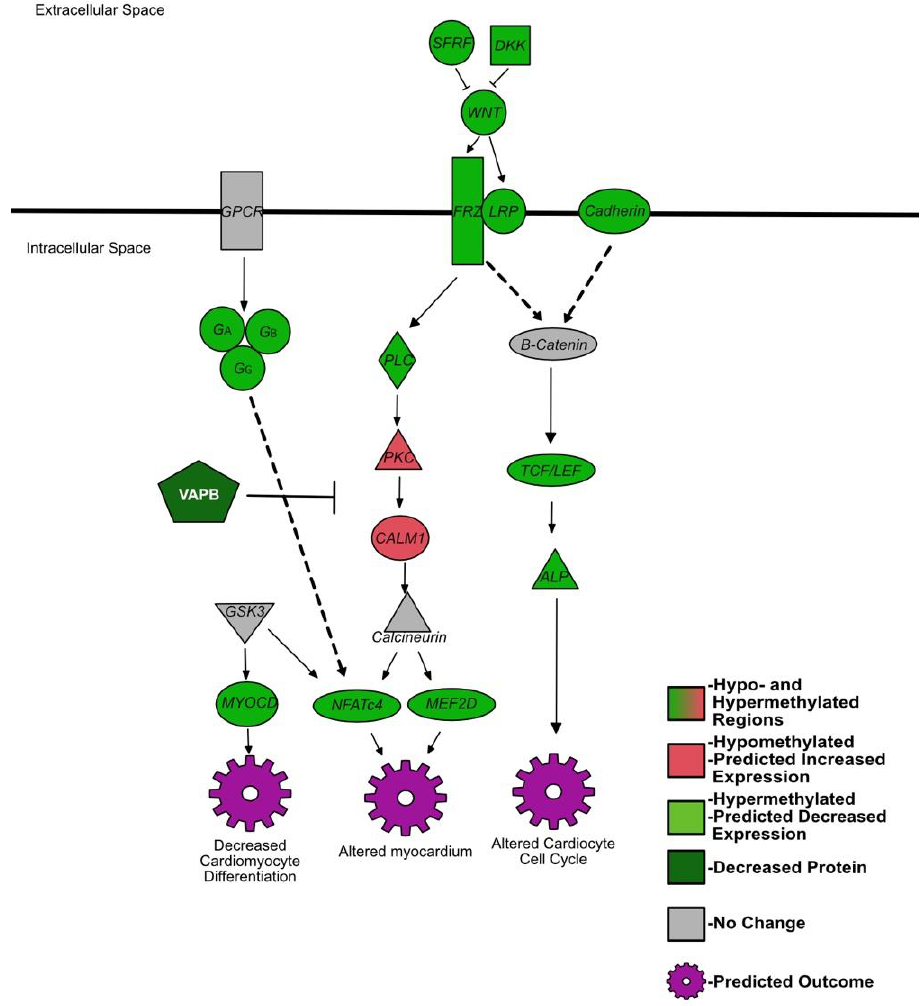
Figure 3. Summarized differentially methylated pathways and genes in PI fetal spleens associated with cardiac development. Green = hypermethylated, predicted decreased expression; red = hypomethylated, predicted increased expression; gray = not differentially methylated or not identified in RRBS; white text = protein.